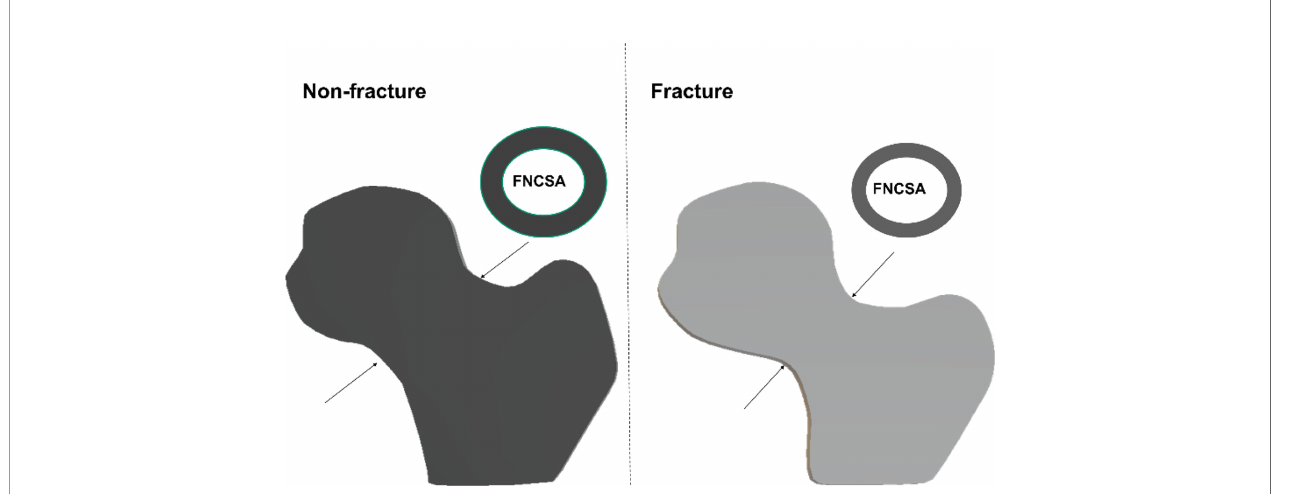
FIGURE 2 | Simple conceptual impression of femoral head volume and femoral neck cross-sectional area (FNCSA) indicates hip fracture subjects with larger head volume [adjusted odd ratio (OR) 1.57; 95% CI 1.30-1.90] and smaller FNCSA (adjusted OR 1.68; 95% CI 1.35-2.10) after adjustment of age, height and